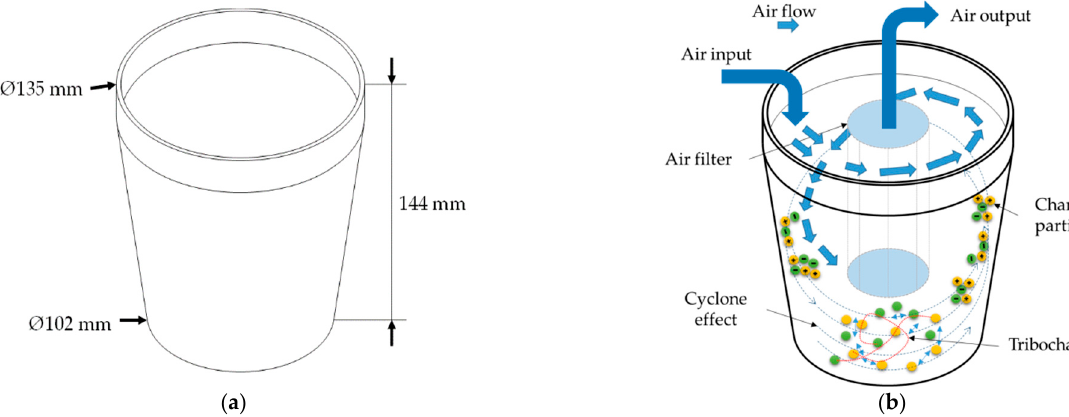
Figure 7. ( a ) Dimensions of the container for circulation of the tested mixed polymers and ( b ) movement of polymer particles during the tribocharging process.